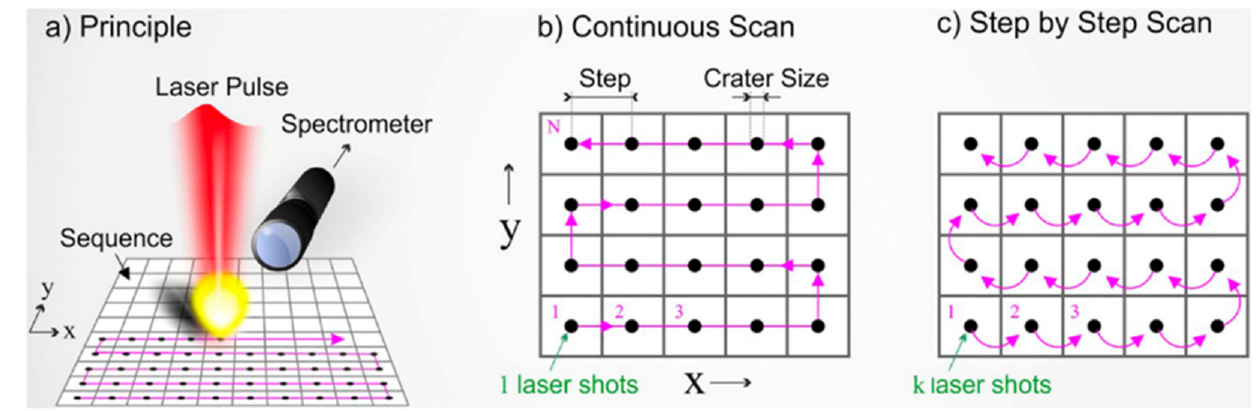
Figure 36. Principle of LIBS scanning and principal configurations of the measurement [195]. ( a ) Raster scan in the laser based AM process. ( b ) Continuous scan path. ( c ) Step-by-step scan path which was not